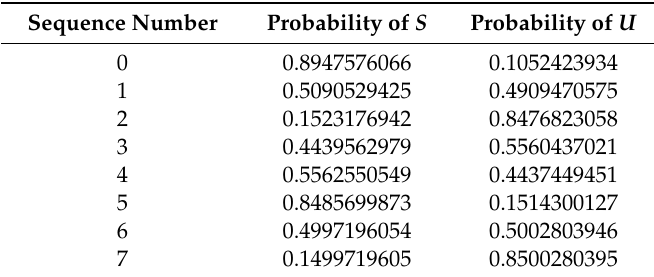
Table 3. HMM probabilities (the sequence is